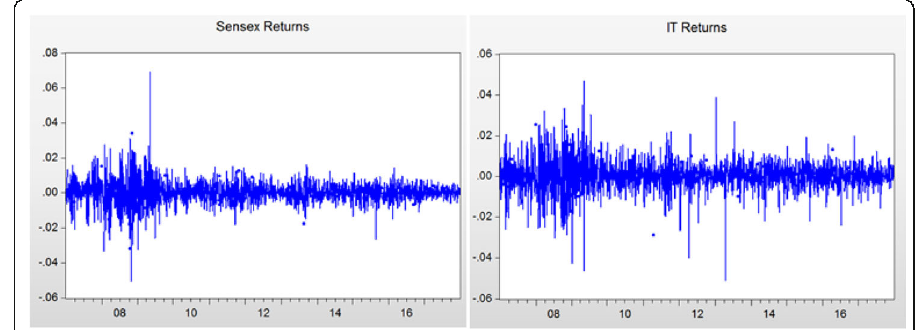
Fig. 1 Line graph for S&P BSE Sensex and S&P BSE IT returns